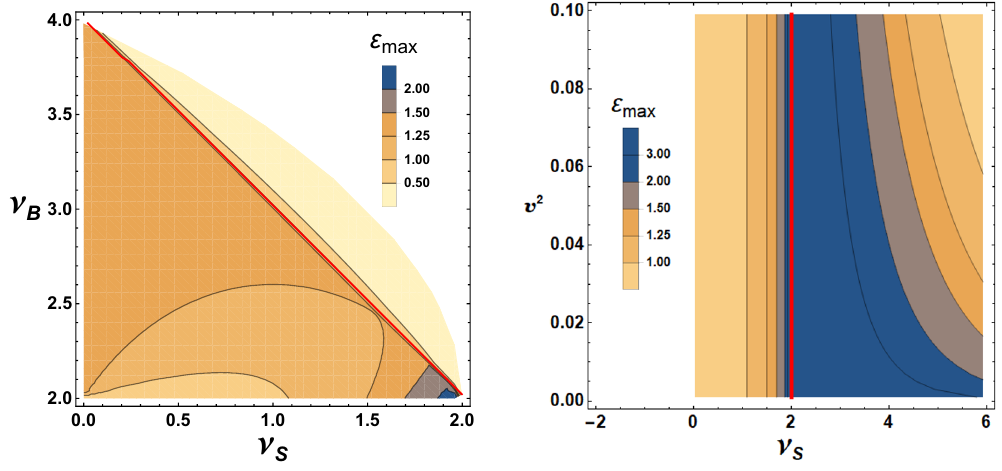
Figure 6 . Left: the maximum allowed strain " max within the allowed region for the monomial EFT case f ( x ) = x (cid:23) S = 2 . The left, bottom and right edges are respectively given by: gradient instability, positivity of the bulk modulus and subluminality. The red line separates the region where " max is controlled by gradient instability and subluminality. Right: the maximum allowed strain " max within the allowed region. SSB case in the particular case where ! = 0 and f ( x ) = 1 + v 2 x (cid:23) S = 2 . The left and bottom edges are respectively given by: gradient instability and positivity of the bulk modulus. The maximum shear strain is determined by gradient instability for (cid:23) S < 2,